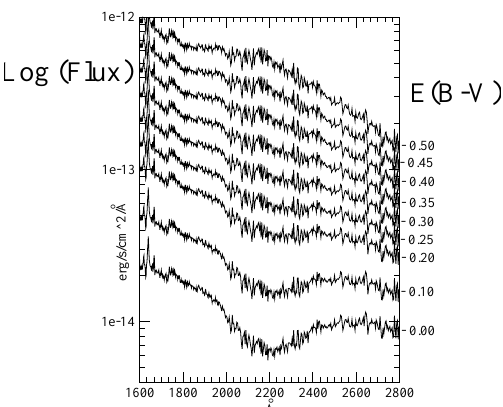
Figure 3: The merged Galex-IUE spectrum of T Pyx has been dereddened for different values of E(B-V) as indicated on the right. The 2175˚A feature associated with the reddening is clearly seen in absoprtion for low balues of E(B-V), and it appears as extra flux for large values of E(B-V). We deduce that the reddening to- wards T Pyx must be E(B-V)=0.35, the value for which the 2175 ˚ A feature